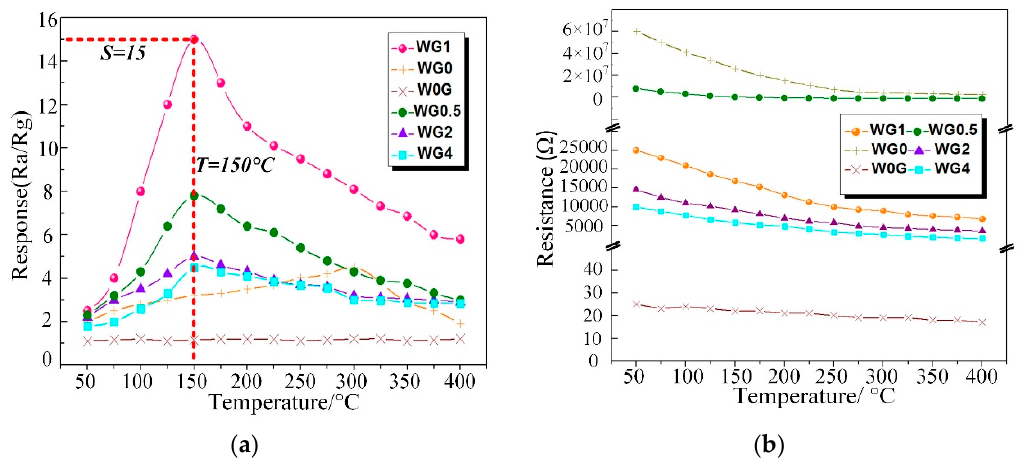
Figure 10. ( a ) Response of W0G, WG0, WG0.5, WG1, WG2, and WG4 to 50 ppm C 2 H 2 at different operating temperature; ( b ) Resistance of W0G, WG0, WG0.5, WG1, WG2, and WG4 at different operating temperature in air.